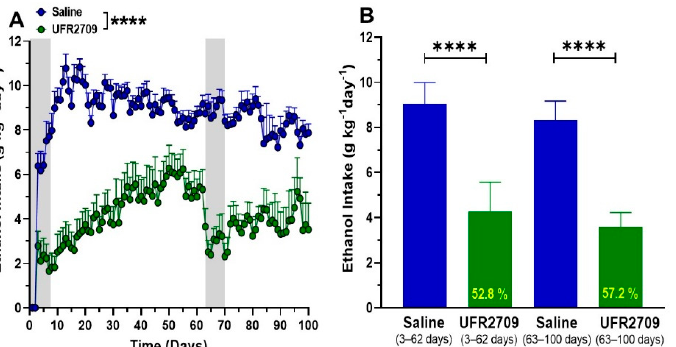
Figure 2. ( A ) A two-bottle free-choice experiment was used to test the effects of a fixed dose of UFR2709 (2.5 mg/kg) on the voluntary ethanol intake of UChB rats per 100 days. Each point represents the average ethanol intake for 7 animals per group during the experiment period. Rats ( n = 7 per group) were administered a single i.p. injection of UFR2709 (2.5 mg/kg/day) or saline (1 mL/kg/day) at 15:00 h, and ethanol consumption was recorded at 14:00 h the next day. Drug administration was made in two stages, the first treatment was the days 1st to 7th and the second treatment was the days 63rd to 69th (labeled in gray in the graph). ( B ) Total average ethanol intake of the two stages of the experiments, days 3–62 in the first period and days 63–100 in the second one. An unpaired t -test was used to compare UFR2709 and saline group averages. Data are expressed as mean ± SEM (g/kg/day), and the number inside the bar indicates the percentage of reduction in ethanol intake compared to the saline-treated group. **** p < 0.0001.